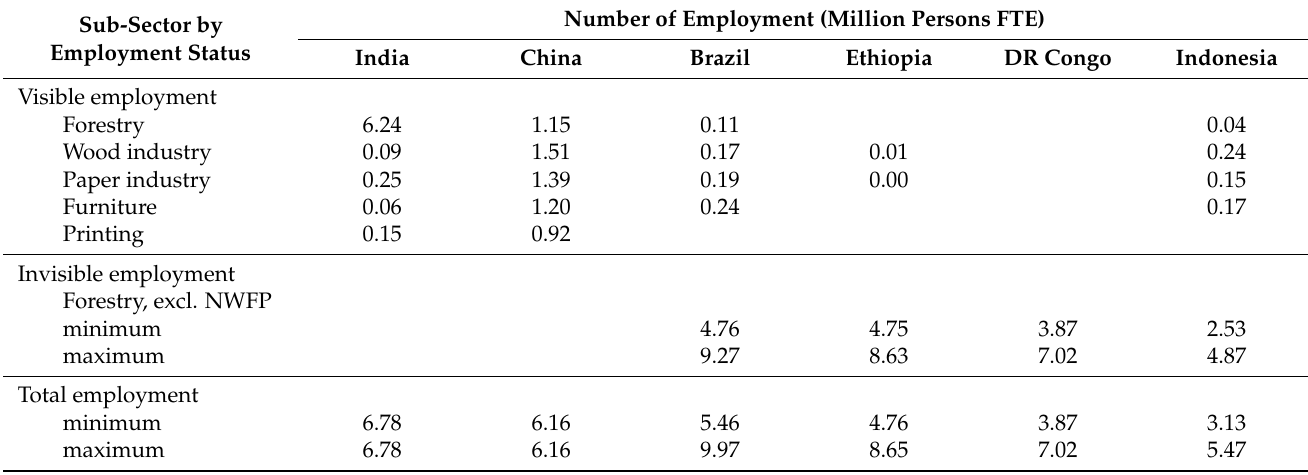
Table 4. Number of visible and invisible employment from selected countries.